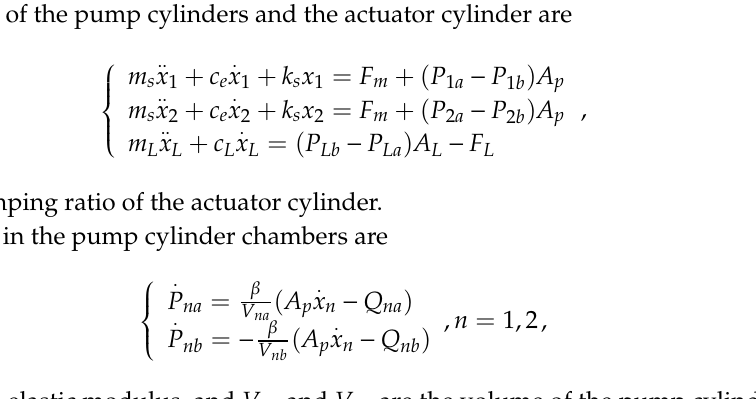
Figure 7. Simplified schematic of the actuator.